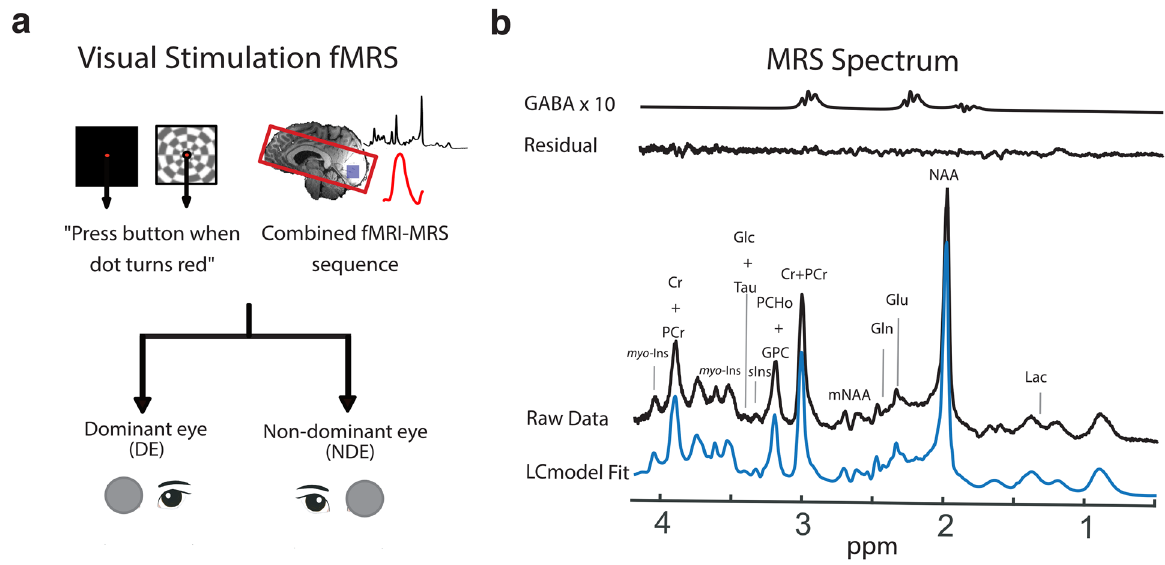
Figure 2. The combined fMRI-MRS monocular visual stimulation paradigm. (a) 7-Tesla combined fMRI-MRS data were collected from the early visual cortex during viewing of visual stimuli through the dominant or non- dominant eye. Visual input comprised of a constant fixation task, while a 50% contrast flashing checkerboard was cycled on (‘checkerboard’) and off (‘fixation’) in the background. (b) A representative MRS spectrum during viewing of visual stimuli through one eye, created by averaging across checkerboard and fixation periods. From bottom to top: blue spectrum shows LCModel fit to raw data. Black spectrum shows raw data. Immediately above are the residuals of the LCModel fit. Topmost line shows the LCModel fit to the GABA signal. For illustrative purposes, the GABA signal was multiplied by ‘EDI’, see “Methods” section, Eq. (1)) was calculated. The EDI measures the increase in duration of the DE phase as a percentage of the NDE phase (range 0.64–23.1%, mean: 7.9 ± 8.2%). Monocular visual stimulation protocol during combined fMRI-MRS acquisition. To measure cortical inhibition during monocular visual stimulation in the visual cortex (Fig. 2a), a 2 × 2 × 2 cm 3 MRS vol- ume-of-interest (VOI) was symmetrically placed along the midline of the calcarine sulcus to cover the early visual cortex (EVC) using a combined fMRI-MRS sequence (see ‘Supplementary Information’). We obtained high quality MRS spectra from the EVC volume (Fig. 2b), including detection of inhibitory neurotransmitter GABA . Across participants, an average of 85 ± 13.7% of the MRS VOI overlapped with the fMRI activation map (checkerboard > fixation), confirming that measurement of the neurochemical levels was measured from visually-stimulated tissue. No difference in percentage overlap was found between monocular stimulation con- ditions (dominant eye: 85 ± 13.7%, non-dominant eye: 86 ± 11.3%, Wilcoxon Rank Sum Test, p = 0.72). Interocular GABA from early visual cortex correlates with eye dominance. Mutual inhibition between neural inputs from each eye to the primary visual cortex is thought to drive eye dominance. To reveal differences in inhibitory responses between the dominant (DE) and non-dominant eye (NDE), participants alternately viewed visual stimuli with either their DE or NDE while the non-stimulated eye was covered with a semi-transparent occluder. Across participants, dominant eye GABA tended to be higher compared to NDE viewing, however the difference was not statistically significant (GABA:H 2 O, paired t -test, t (11) = 2.13, p = 0.06; GABA:tCr, paired t -test, t (11) = 1.72, p = 0.11). The difference in GABA levels between eyes was then quantified as a single metric, the ‘interocular’ GABA (Fig. 3a). We related the behaviourally derived eye dominance index (EDI), measured in the binocular rivalry experiment, to interocular GABA. EDI was significantly correlated with interocular GABA when using GABA scaled to the internal reference signal of unsuppressed water (Fig. 3b, GABA:H 2 O, Spearman’s Rank Correlation r = 0.62, uncorrected p = 0.037). To control for the possibility that the metabolite reference method influenced the results, we also scaled GABA to the summed signal of cre- atine and phosphocreatine (‘GABA:tCr’). The correlation remained significant (GABA:tCr, r = 0.59, uncorrected p = 0.049). In an exploratory analysis of this relationship, we show that there is no correlation between EDI and dominant eye GABA (Fig. 3c: Spearman’s Rank Correlation, GABA:H 2 O, r = − 0.11, p = 0.73; GABA:tCr, r = − 0.06, p = 0.83), but a negative association between EDI with non-dominant eye GABA (Fig. 3d: Spearman’s Rank Correlation, GABA:H 2 O, r = − 0.59, p = 0.048; GABA:tCr, r = − 0.61, p = 0.037). We conclude that stronger eye dominance corresponds to a greater difference in GABAergic inhibition during dominant compared to non-dominant eye stimulation. Investigating the correlation within conditions suggested that the effect is partly accounted for by a failure of the NDE to inhibit the DE, as stronger eye dominance was associated with lower GABA during stimulation of the weaker eye.